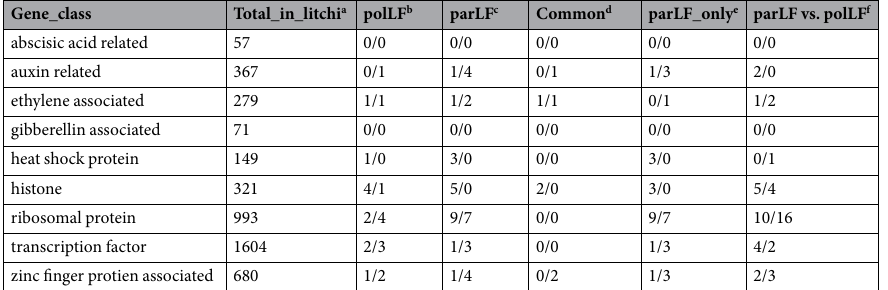
Table 3. DEPs in polLFs and parLFs during the early developmental process. a Total number of genes annotated in litchi genome. b Number of DEPs in polLFs, up-regulated/down-regulated. c Number of DEPs in parLFs, up-regulated/down-regulated. d Number of DEPs in both polLFs and parLFs, up-regulated/down-regulated. e Number of DEPs exclusively in parLFs, up-regulated/down-regulated. f Number of DEPs in parLFs compared to polLFs,